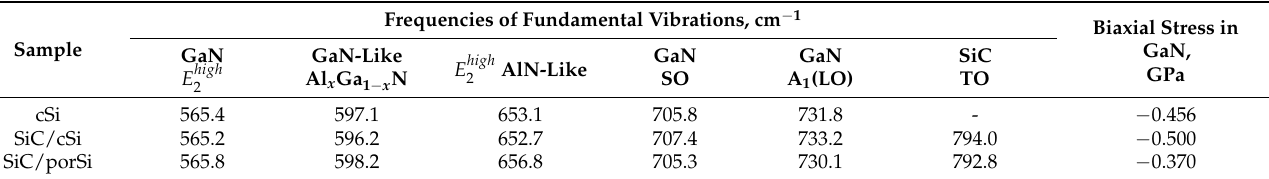
Table 1. Frequencies of the fundamental vibrations attributed to GaN, AlN, and Al x Ga 1 − x N from the Raman spectra decomposition